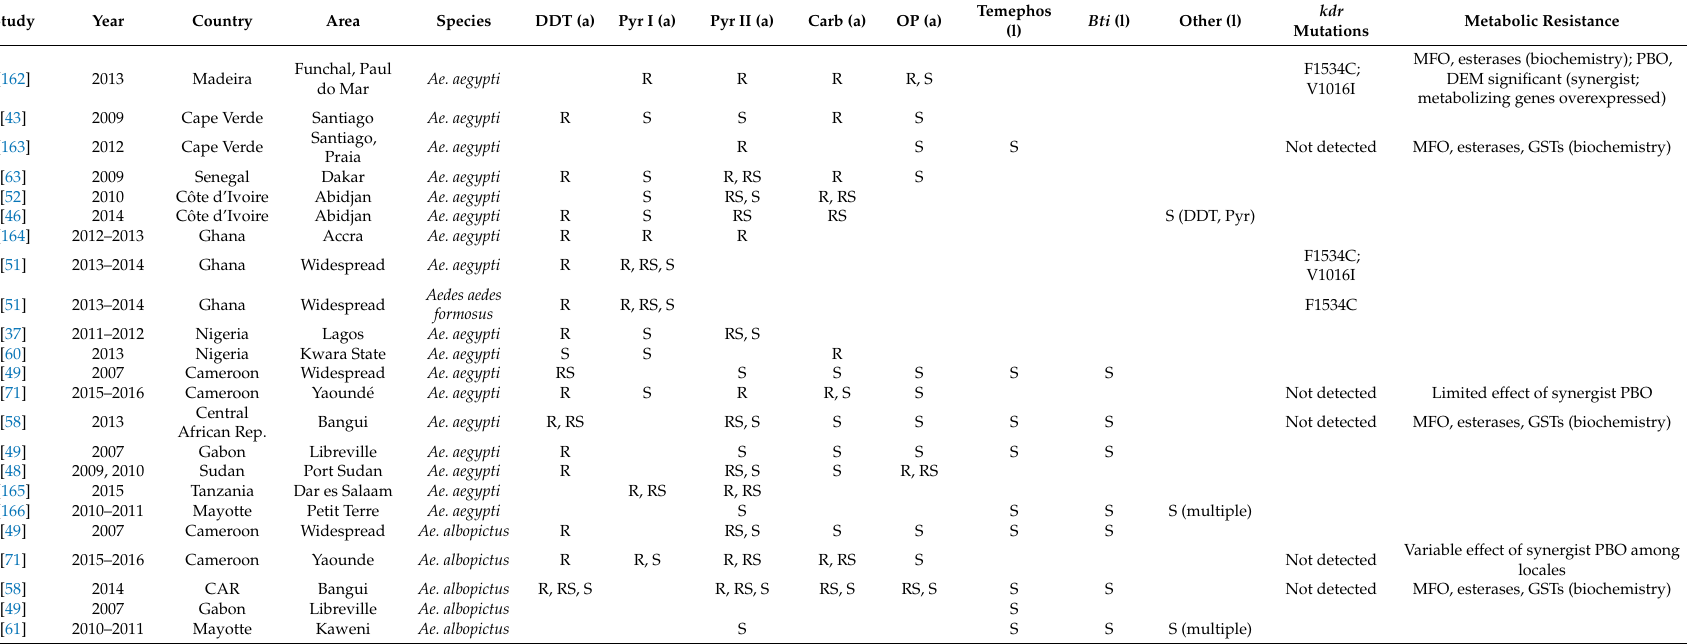
Table 2. Records of insecticide resistance in Aedes species (1990 onwards) from African mainland countries and islands. Resistance is classified according to WHO standards as resistant (R) < 90% mortality, suspected resistance (RS) 90–97% mortality, or susceptible (S) > 97% mortality in adult (a) tube or larval (l) bioassays. Brief details of resistance mechanisms are shown where reported. Studies are ordered by species, then from North-West toward South-East. Blank cells indicate that the phenotype or mechanism was not